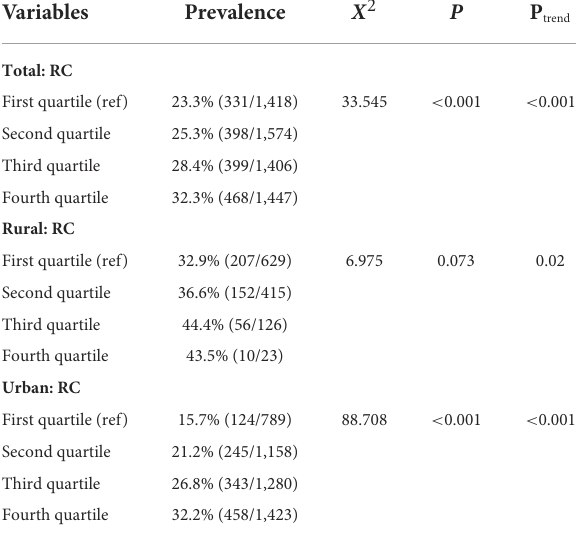
FIGURE3 The prevalence of abdominal obesity among remnant cholesterol (RC) quartiles in